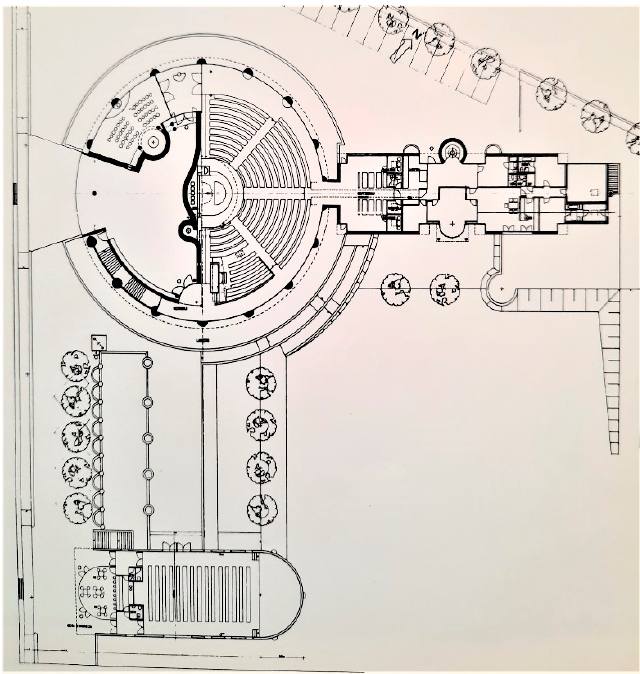
Figure 2. Plan of the complex. The pre-existing chapel is located at the bottom of the plan.